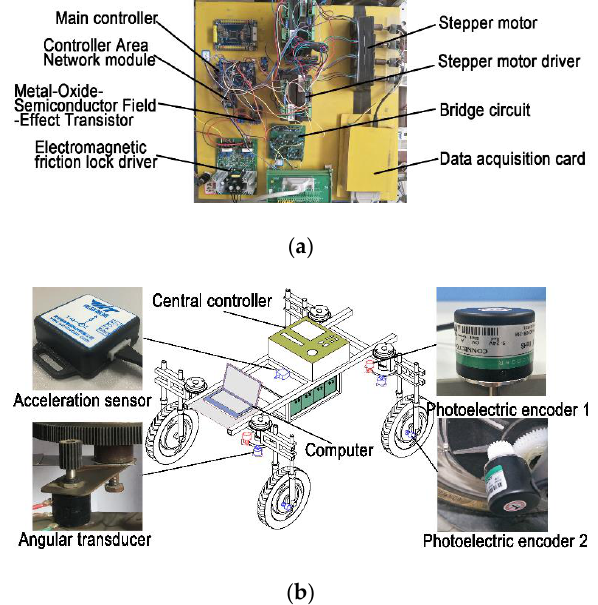
Figure 13. Control panel for FC motion mode switching: ( a ) control panel; ( b ) configuration of flexible chassis used for test.